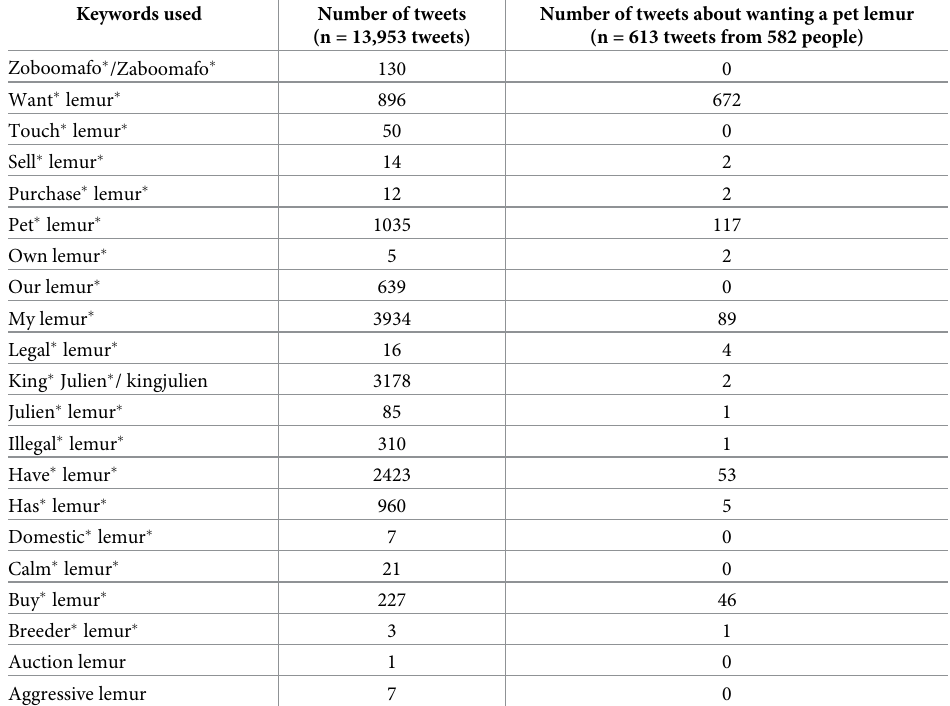
Table 1. Keywords used to capture tweets regarding pet lemurs, number of tweets pulled from the Twitter API using each keyword, and number of tweets about people wanting to have a pet lemur. Keywords